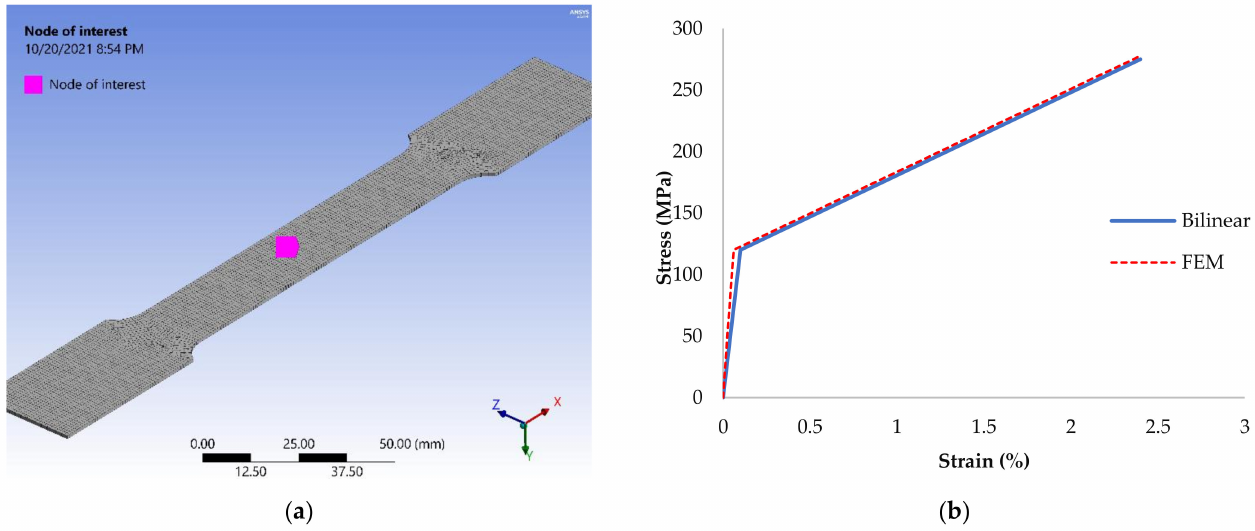
Figure 21. Stress–strain curve: ( a ) node of interest central position; ( b ) stress–strain curves for material definition bilinear and finite element model in node of interest.